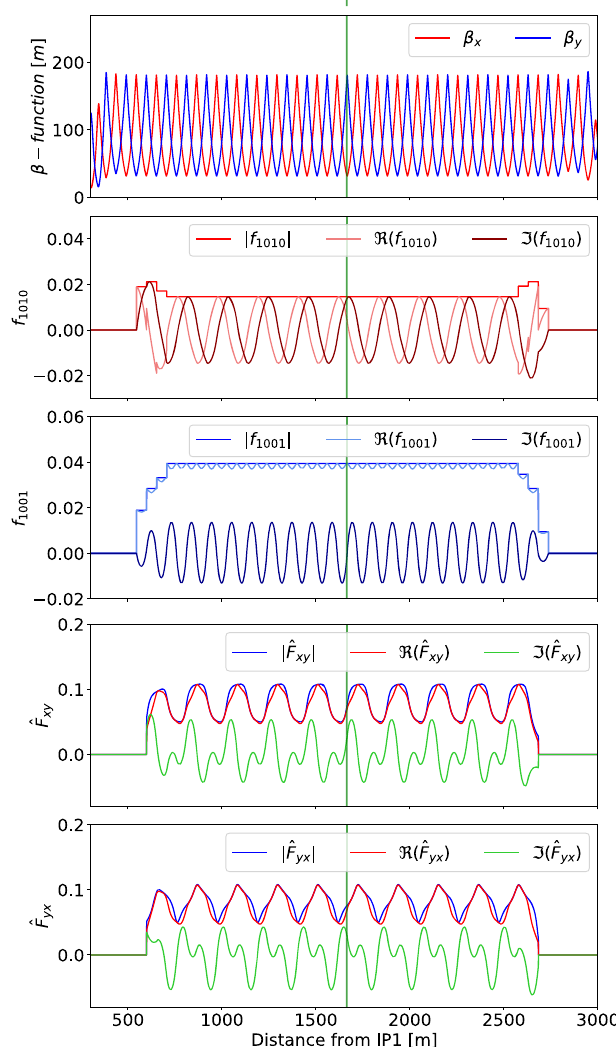
FIG. 5. Illustration of the four corrector coupling bump created through the arc 12 right of IP1. The position of the octupole is indicated with a green line.